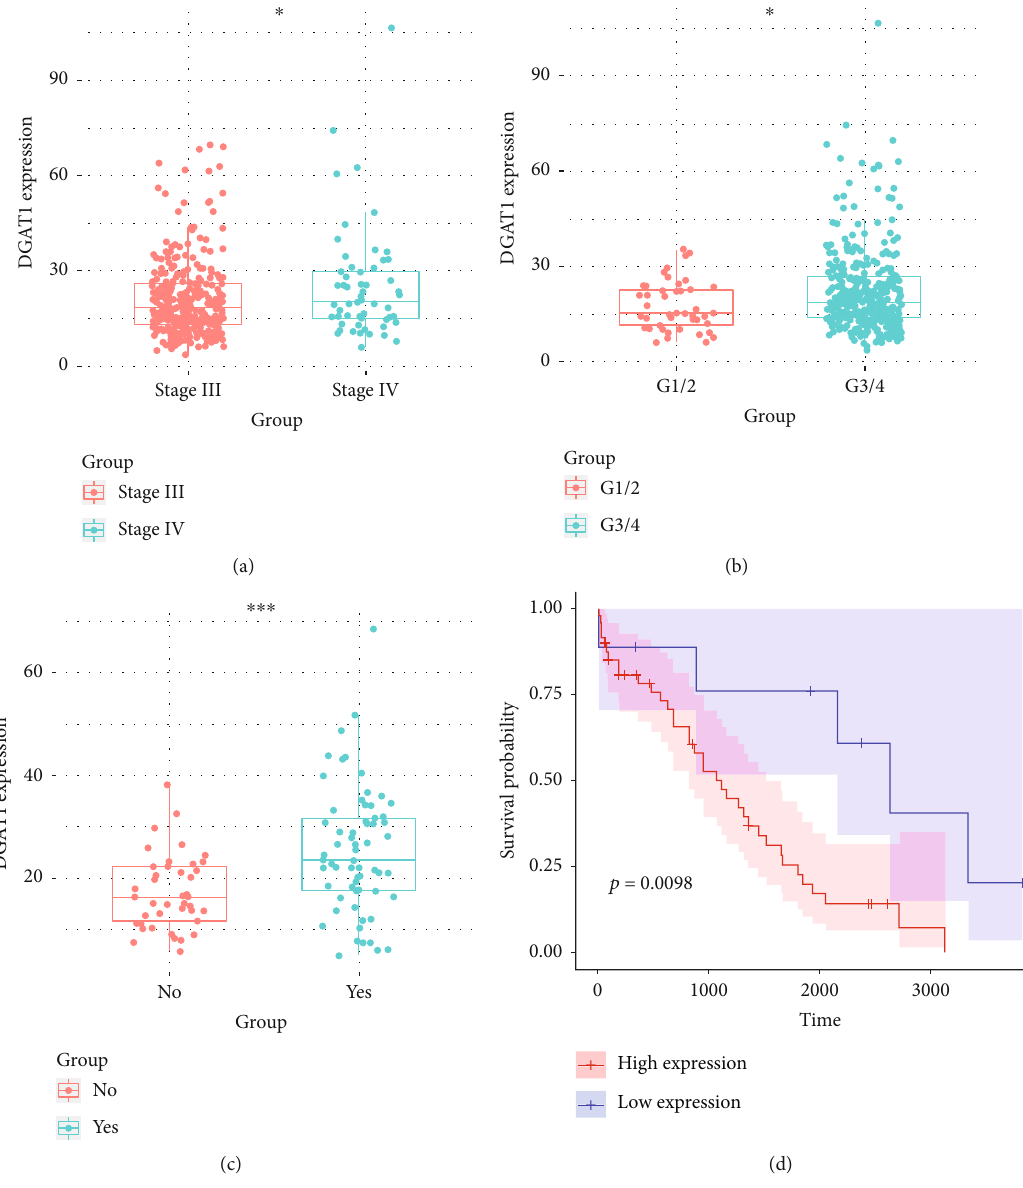
Figure 1: Upregulation of DGAT1 expression is associated with poor survival in ovarian cancer. (a) DGAT1 expression is upregulated in stage IV ovarian cancer as compared to stage III. (b) DGAT1 expression is upregulated in histological grade 3/4 as compared to histological grade 1/2. (c) DGAT1 is overexpressed in patients with venous invasion as compared to those without venous invasion. (d) Patients in stage IV with higher expression of DGAT1 have an unfavorable prognosis as compared to those with lower expression of DGAT1 ( p ≤ : 05 = ∗ , p ≤ : 001 = ∗∗∗